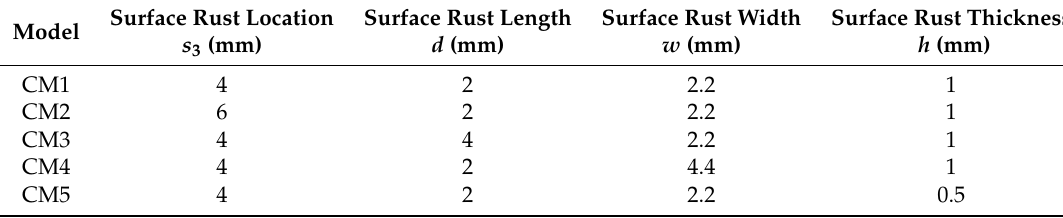
Table 2. Five corroded steel rod